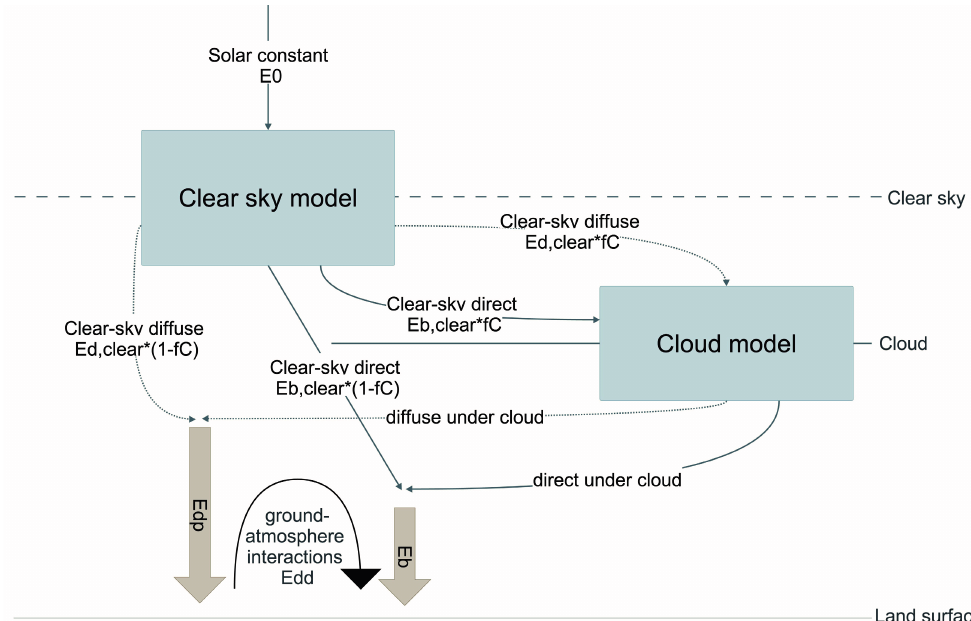
Figure 1. Schematic diagram of the method used in this study to estimate each component of the downward solar radiation. The definition of each variable in the flowchart can be found in Table 1.